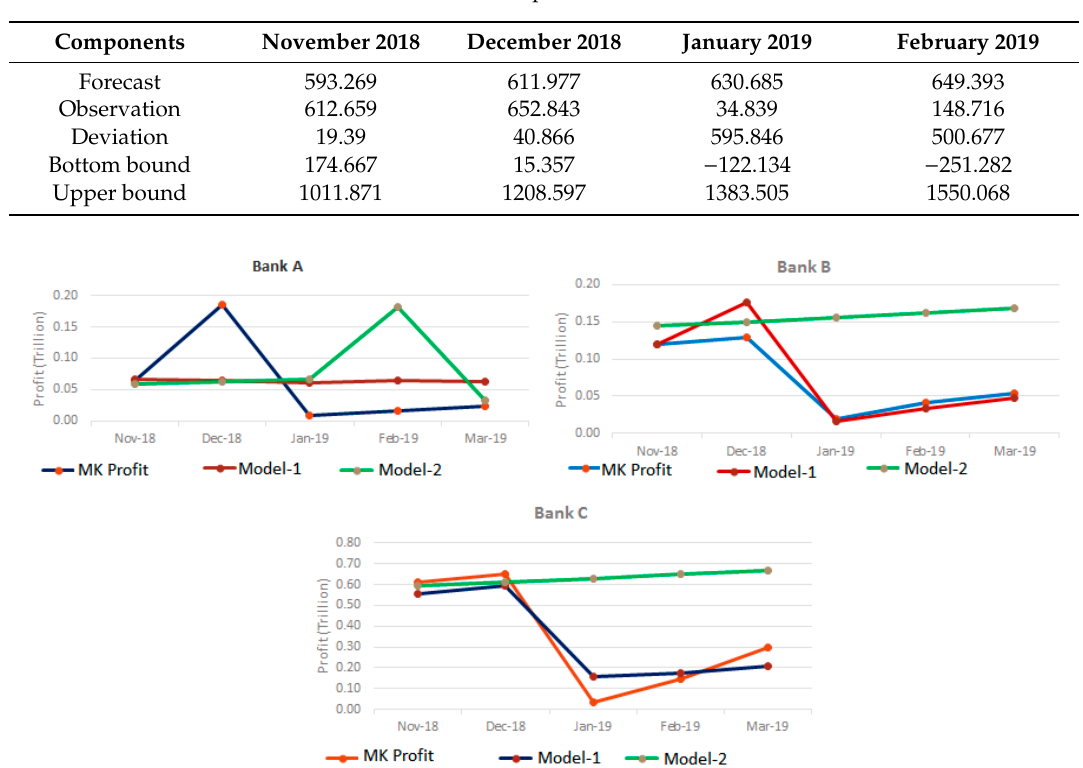
Table A3. Models-2 forecast profit of Bank C in IDR trillion.